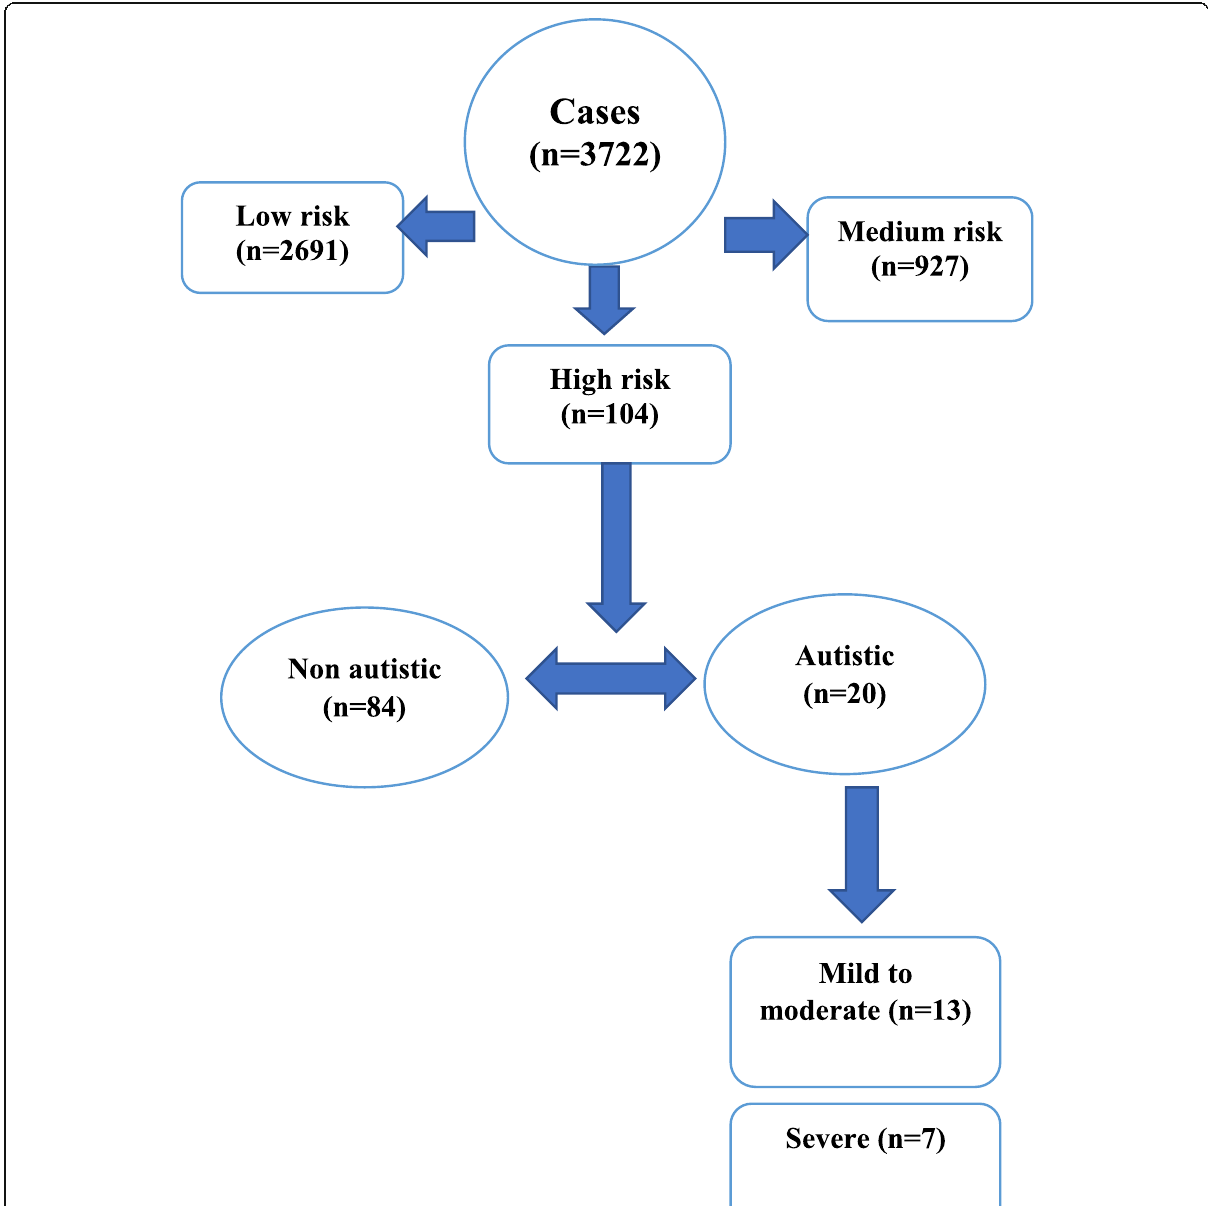
Fig. 1 Flow chart illustrating the distribution of cases from the start till the end of the